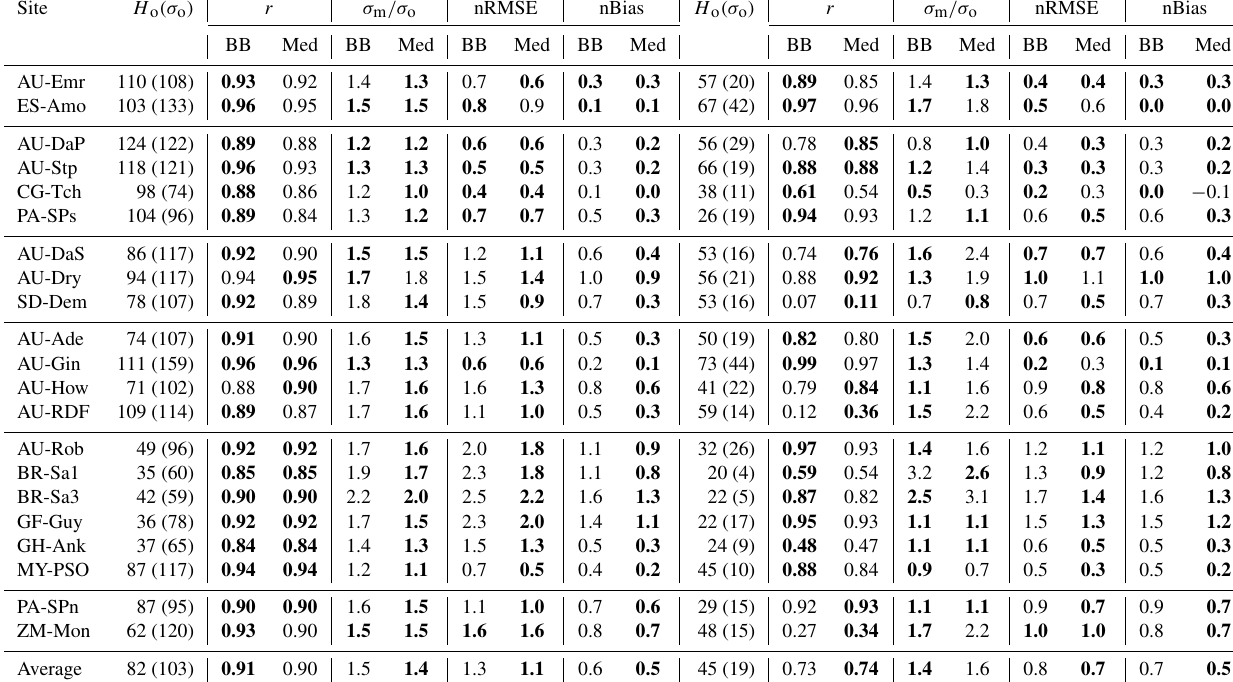
Table 6. Model performance statistics for simulated hourly (left) and monthly (right) sensible heat fluxes for the CLM/BB and CLM/Med simulations. Bold fonts indicate the model configuration that performed better. The mean and standard deviation of the observed fluxes ( H o and σ o , respectively), shown for reference, are given in Wm − 2 . The RMSE and bias have been normalized by the mean of the observed fluxes for easier cross-site